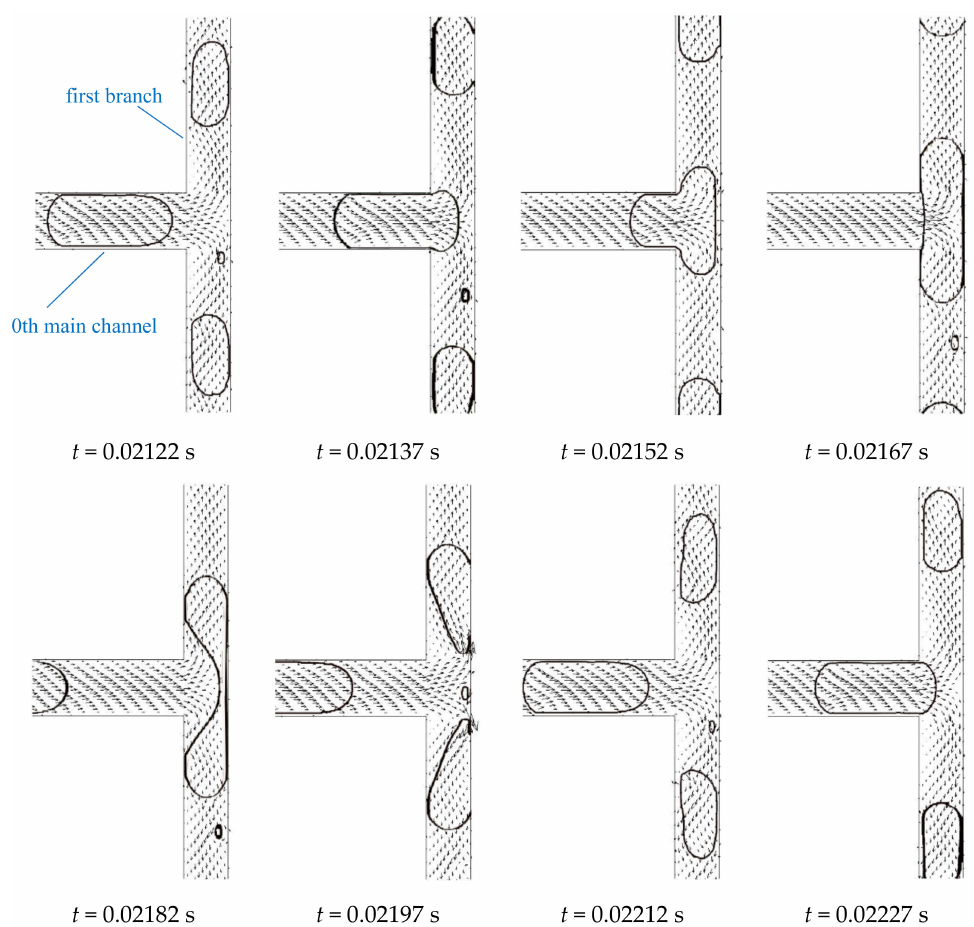
Figure 2. Bubble breakup at the first bifurcation of the fractal tree-shaped microchannel (Ca 0 =